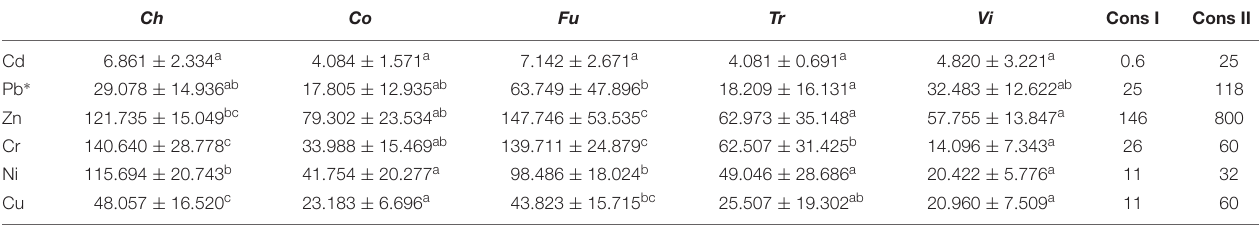
TABLE 5 | Concentration for trace elements (mg/kg) and standard deviation in the wetland sediments analyzed in the present work. Ch Co Fu Tr